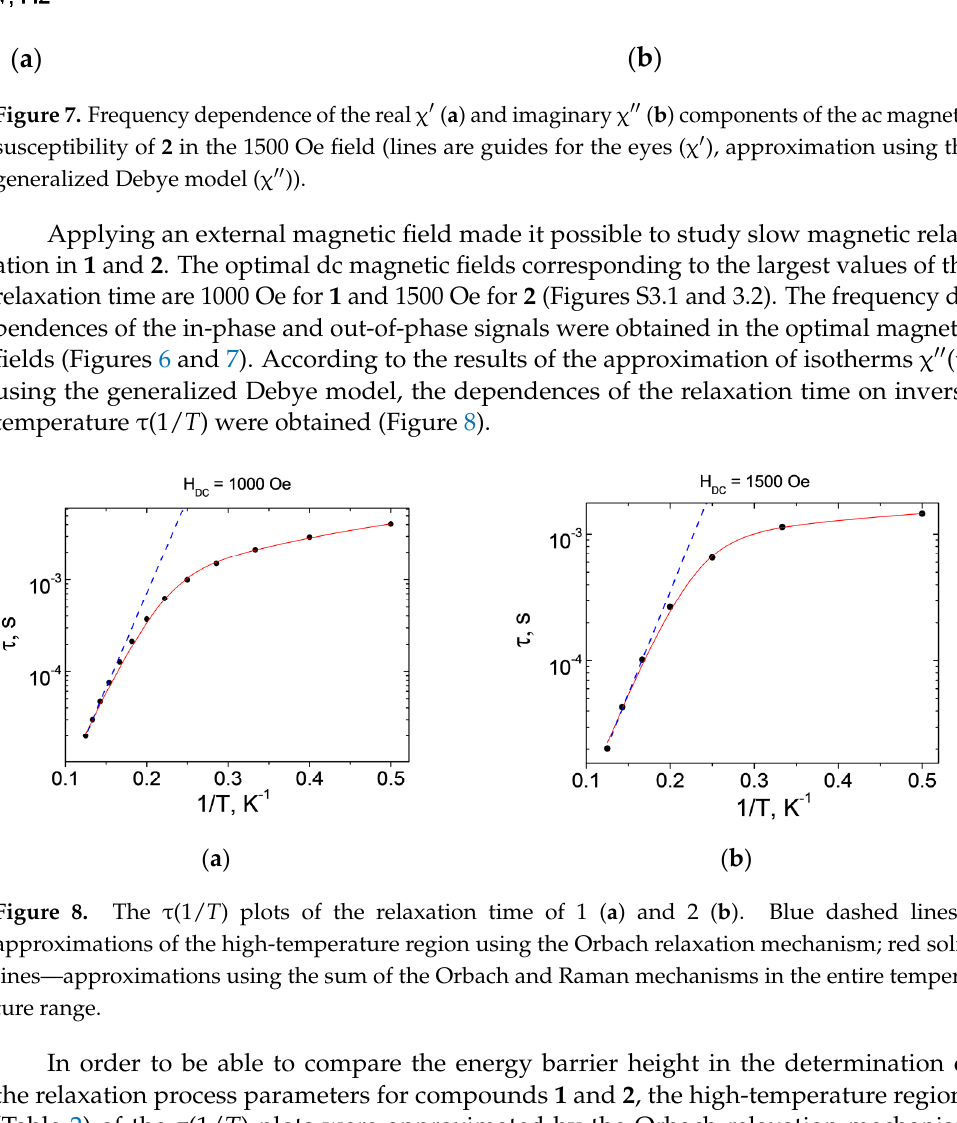
Figure 7. Frequency dependence of the real χ ’ ( a ) and imaginary χ ’’ ( b ) components of the ac mag- netic susceptibility of 2 in the 1500 Oe field (lines are guides for the eyes ( χ ’), approximation using the generalized Debye model ( χ ’’)).